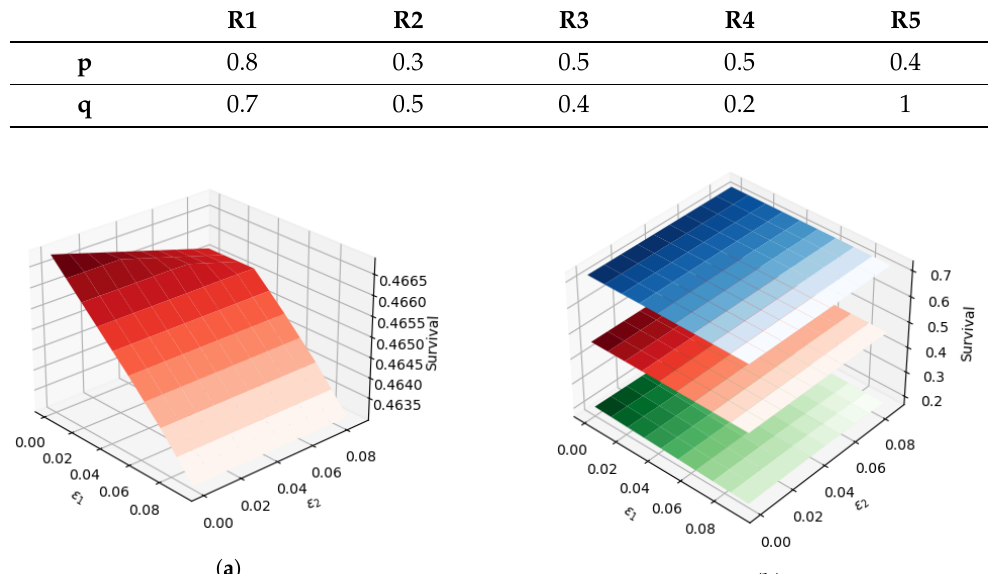
Table 7. Energy ( p ) and Latency ( q ) for each routing mechanism in Case Study-3.